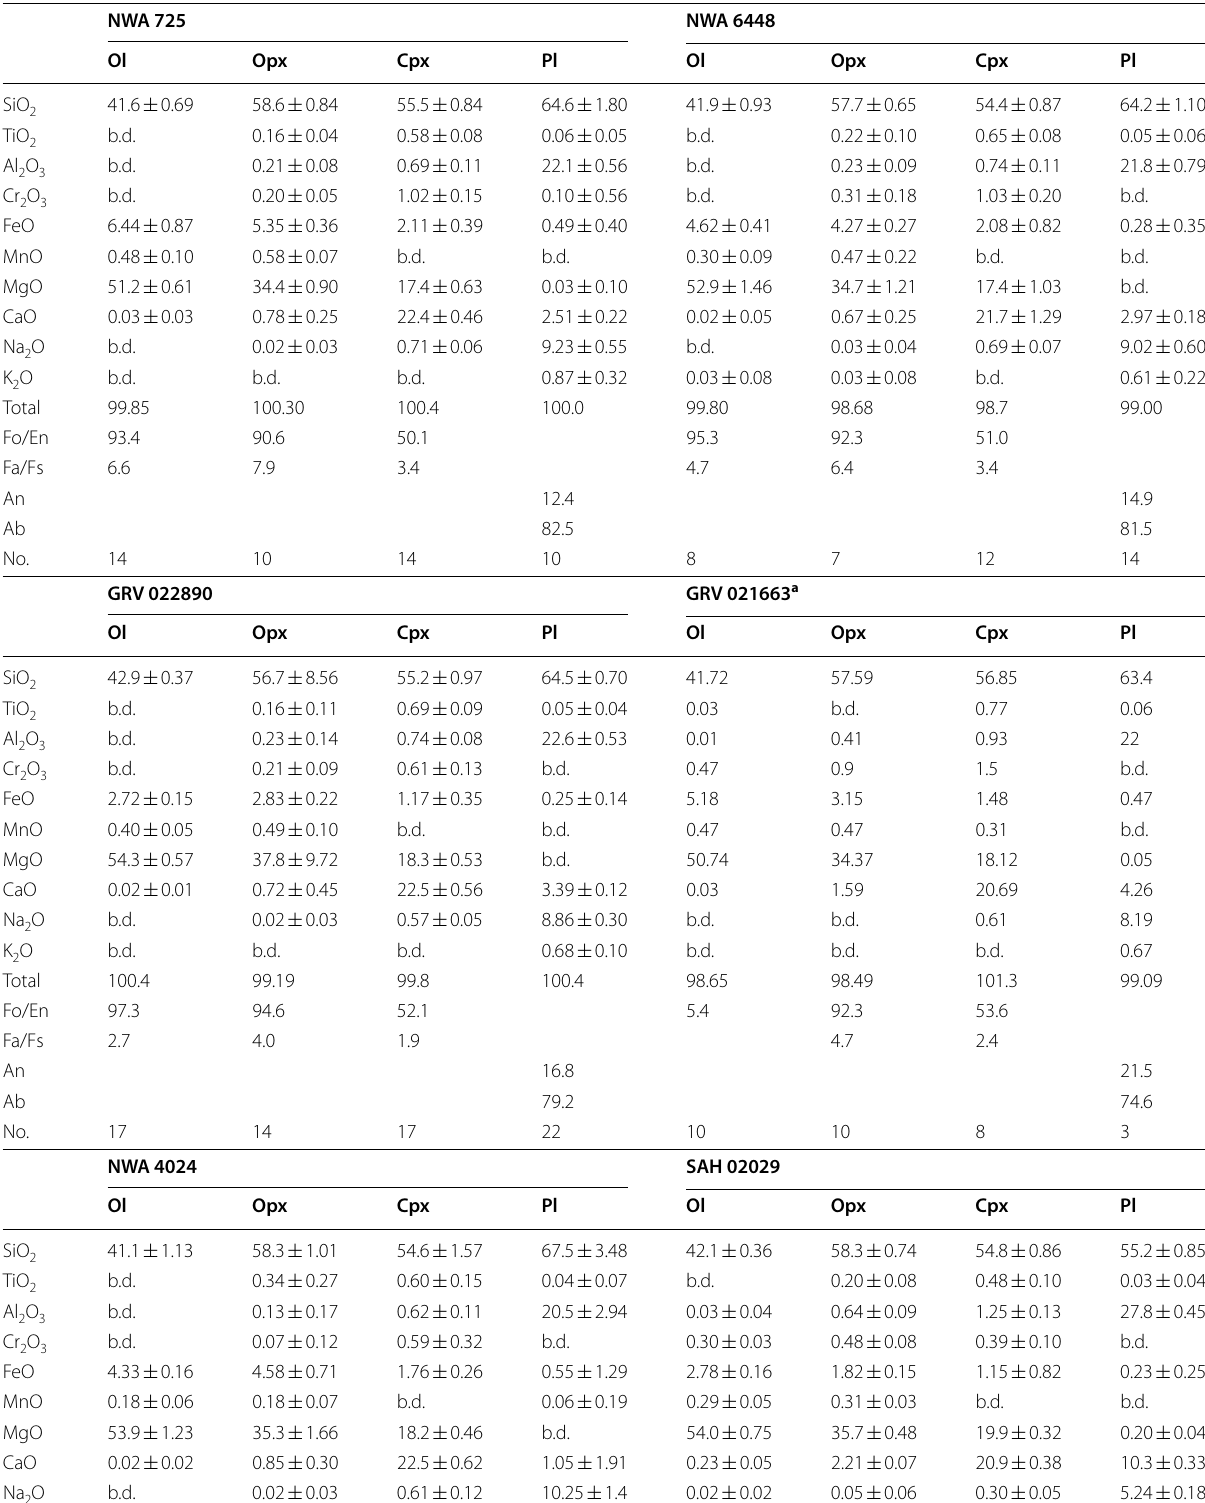
Table 2 Average major composition of olivine (Ol), orthopyroxene (Opx), clinopyroxene (Cpx), and plagioclase (Pl) in the studied winonaites (wt%) NWA